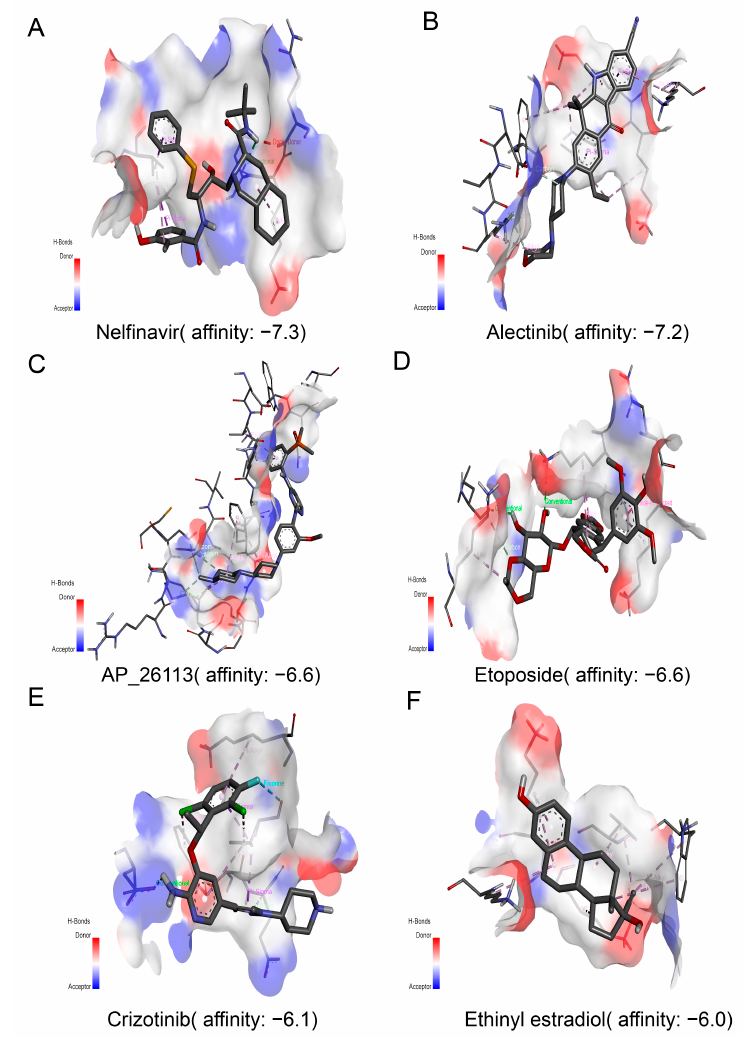
Figure 7. Molecular docking analysis for identification of small molecular drug for target CXCL9.